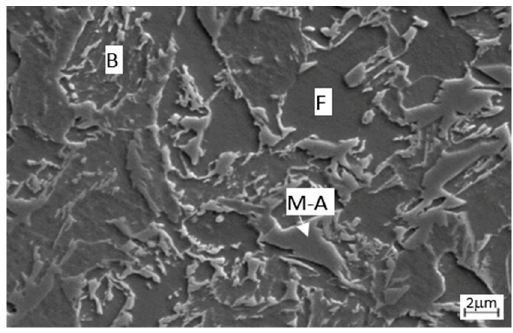
Figure 12. Heat treatment parameters: Soaking 850 °C/100 s, cooling rate 30 °C/s, bainitic hold 375 °C/600 s. Ferritic-bainitic microstructure with M-A constituent and very fine pearlite. Metals 2017 , 7 , 537 10 of 14